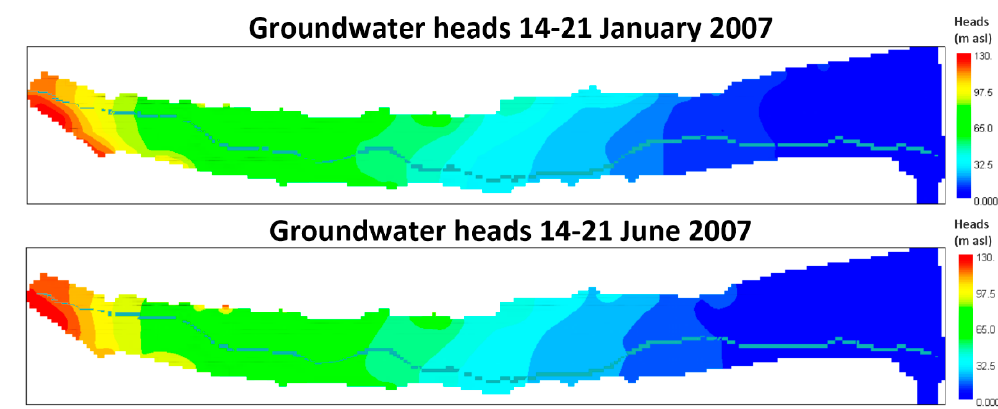
Figure 4. Scatter diagrams of calculated versus observed groundwater heads for the calibrated model in January 2007 ( left graph ) and in June 2007 ( right graph ). The model performance indica- tors are also reported.